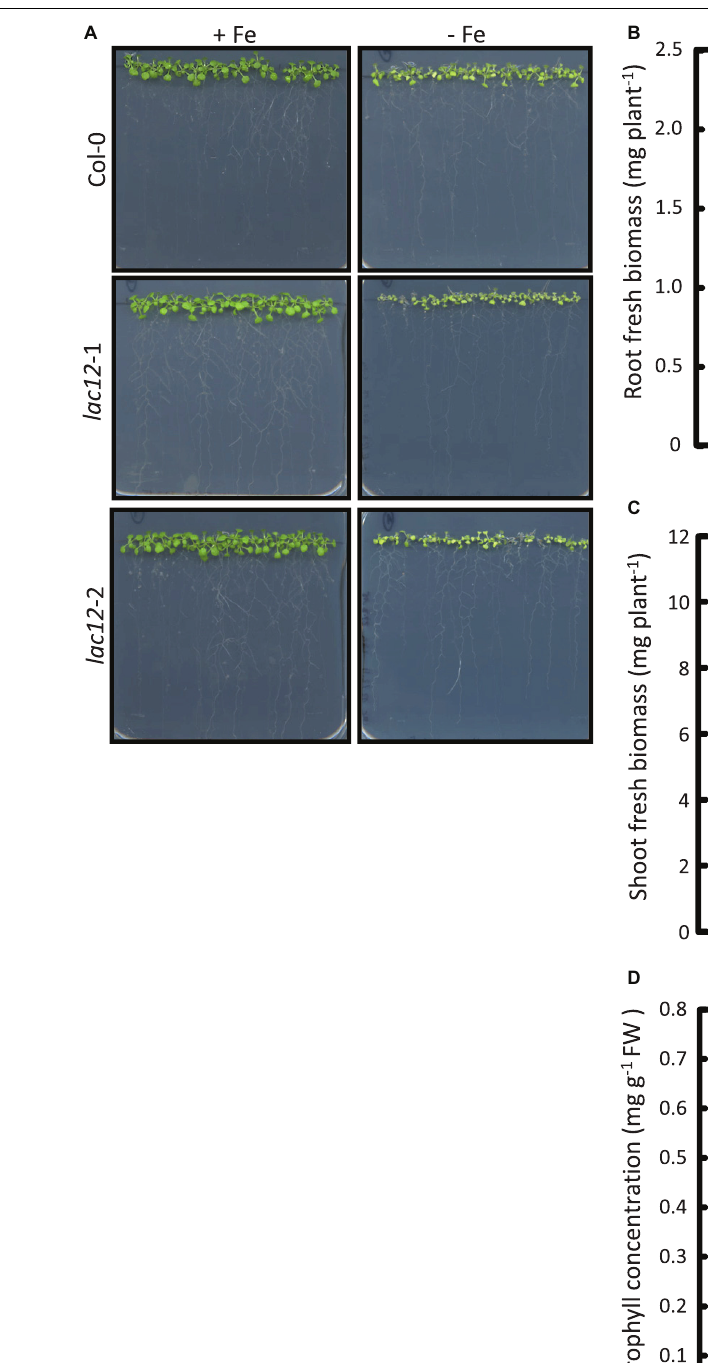
Frontiers in Plant Science |